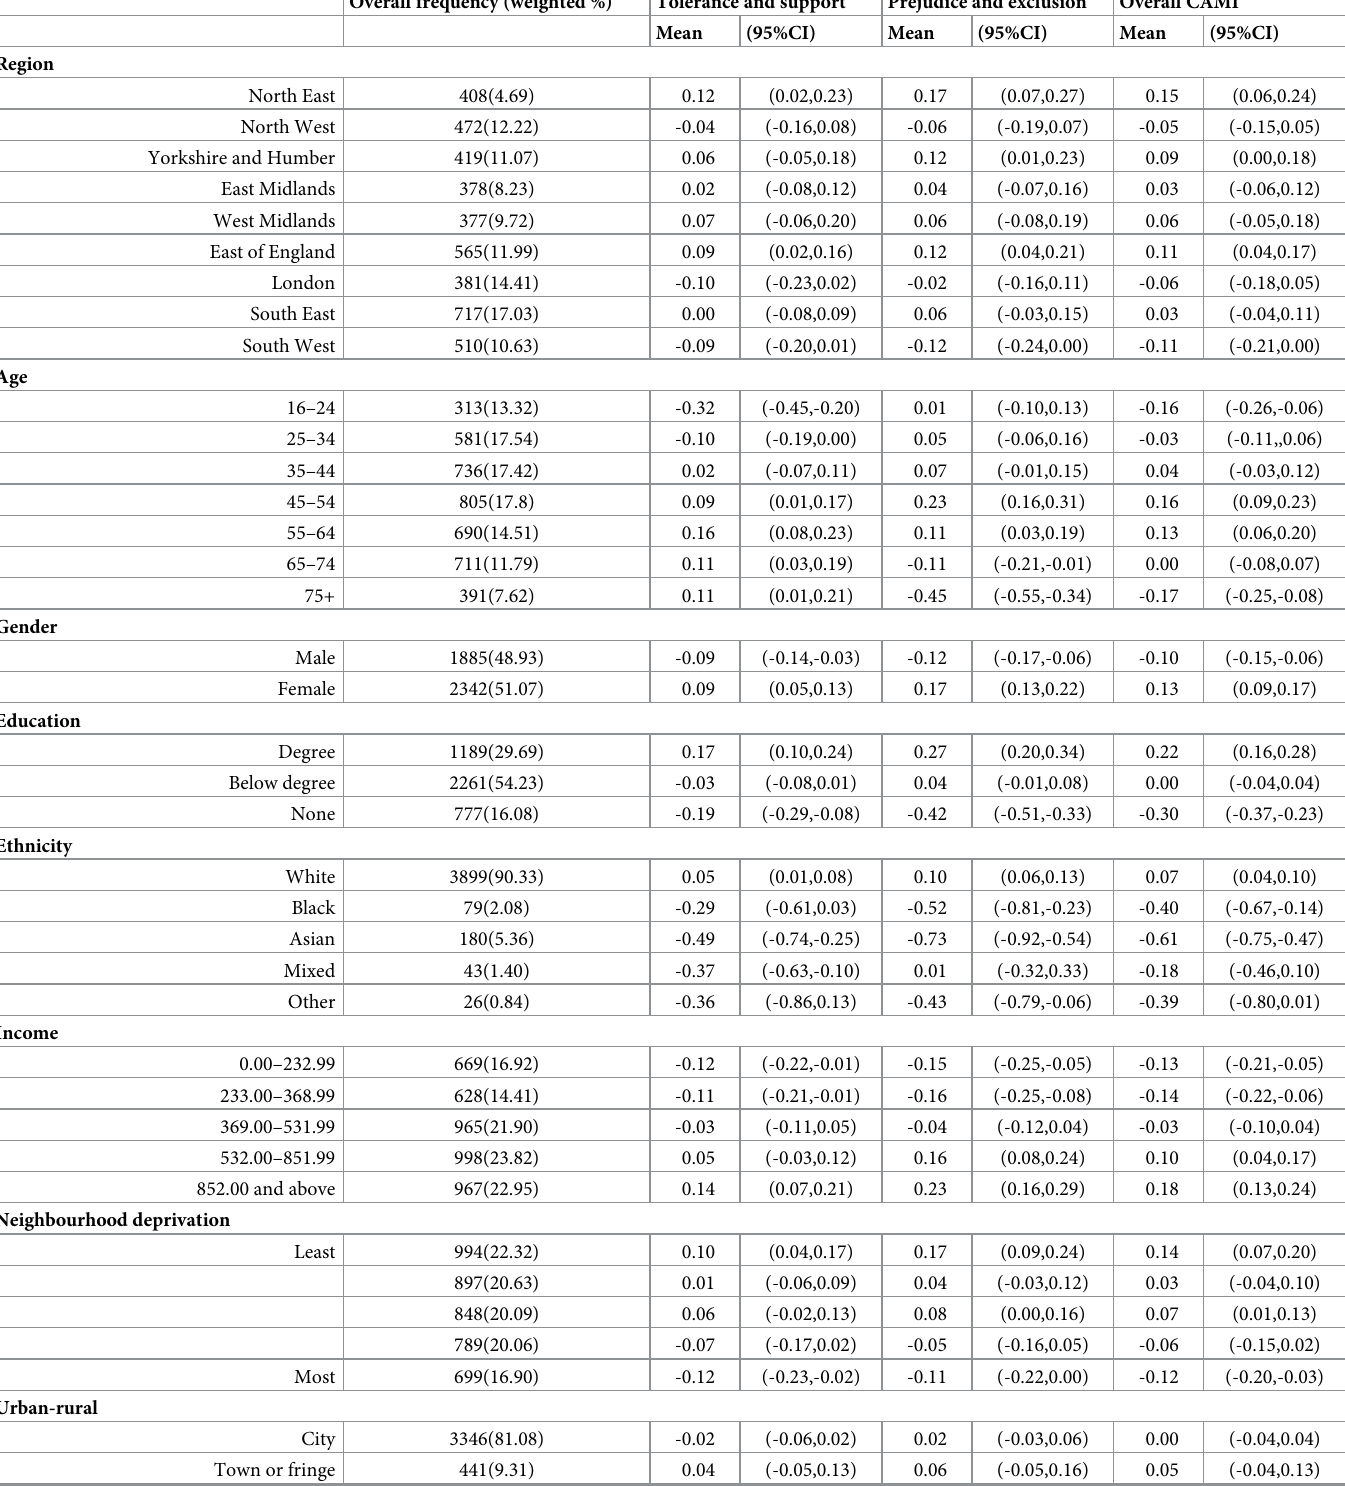
Table 5. Description of study population in terms of mental health-related attitudes, based on responses to the CAMI, from the analysed sample (N =